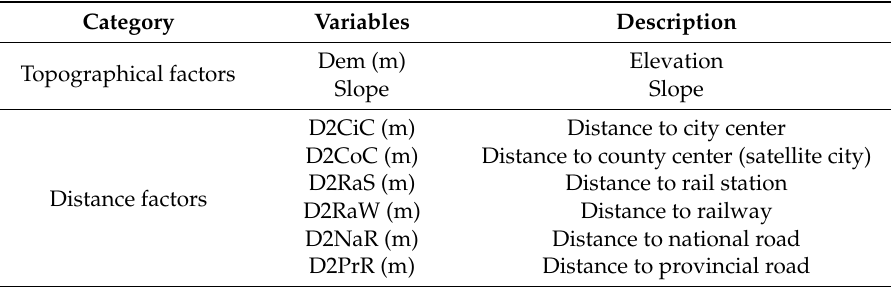
Table 2. List of the selected drivers of rural residential settlement